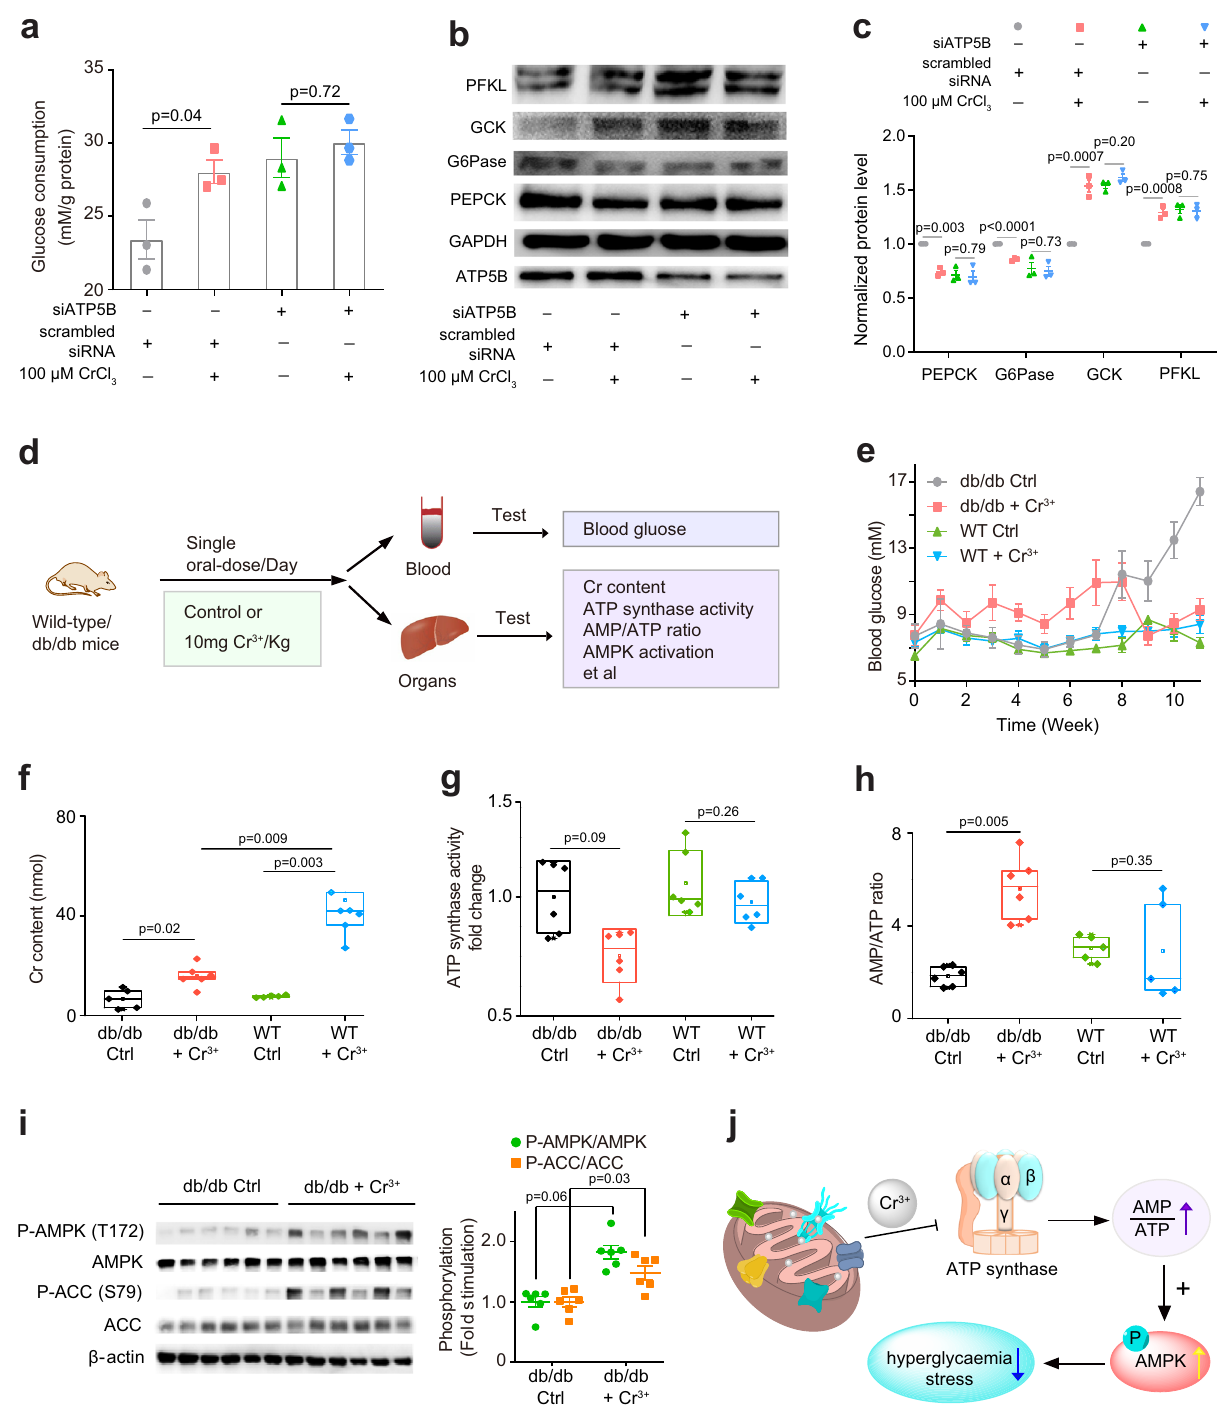
Fig.4|Cr 3+ ameliorateshyperglycaemiastressthroughtargetingATPsynthase in cells and diabetic mice. a Comparison of glucose consumption in HepG2 cells. n =3; mean±SEM. Two-sided Student ’ s t test. Representative western blot ( b ) and quanti fi cation results ( c ) showing the effect of ATP5B gene silencing on Cr 3+ - mediated regulation of glycolysis and glycogenesis enzymes in HepG2 cells. n =3; mean±SEM. Two-sided Student ’ s t test. d Schematic illustration of animal study. e Blood glucoselevelsindb/dbandwild-type(WT)micewithorwithouttreatment of Cr 3+ ( n =6). f Cr 3+ contents in the livers of both db/db and wild-type (WT) mice with or without treatment of Cr 3+ ( n =6). g Cr 3+ inhibits ATP synthase activity in